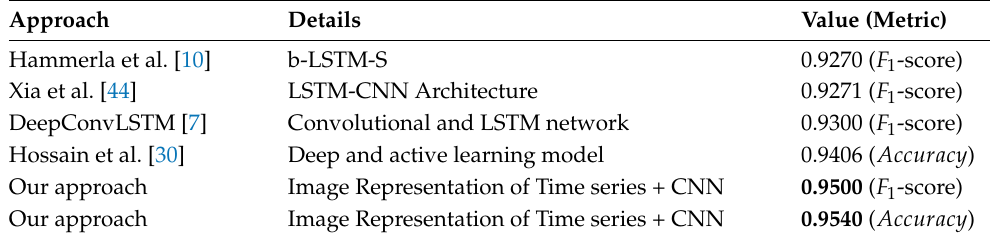
Table 6. Comparison considering Opportunity